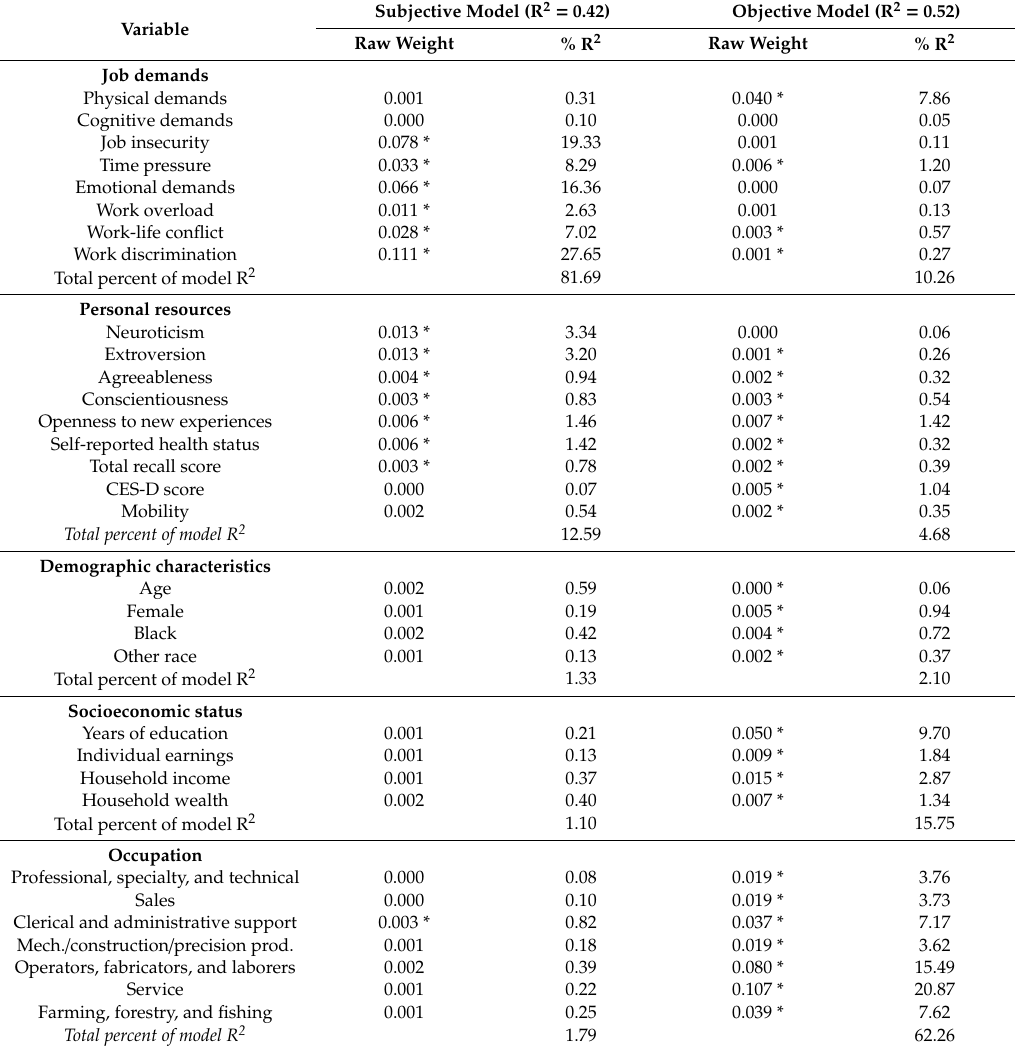
Table 6. Relative weights analysis for subjective HRS and objective O*NET job resource